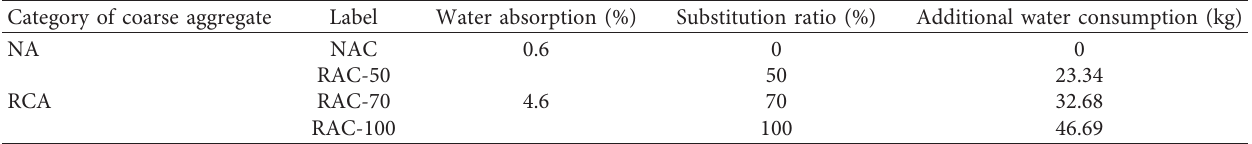
Table 3: Additional water consumption per unit volume.